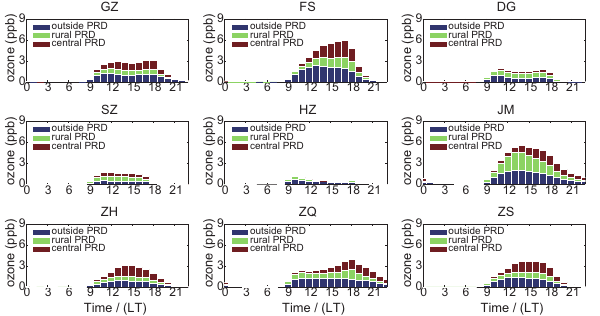
Fig. 10. Diurnal variation of the surface ozone increment in PRD cities due to BVOC emissions from different regions.